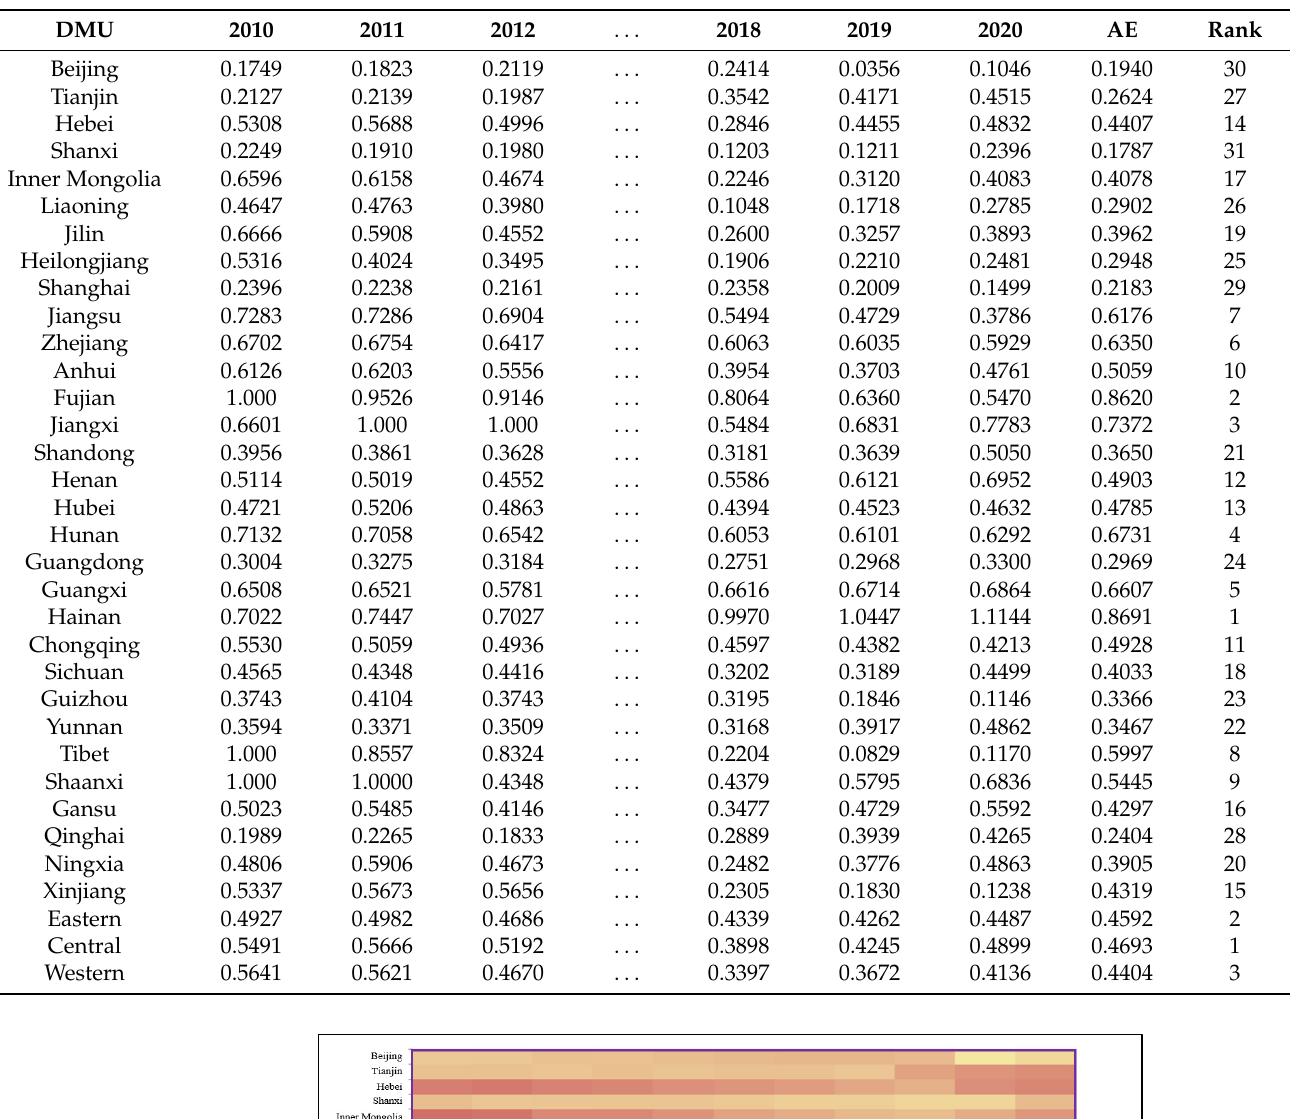
Table 4. Production efficiency values of the construction industry after bootstrap-DEA correction in 31 provinces from 2010 to 2020.